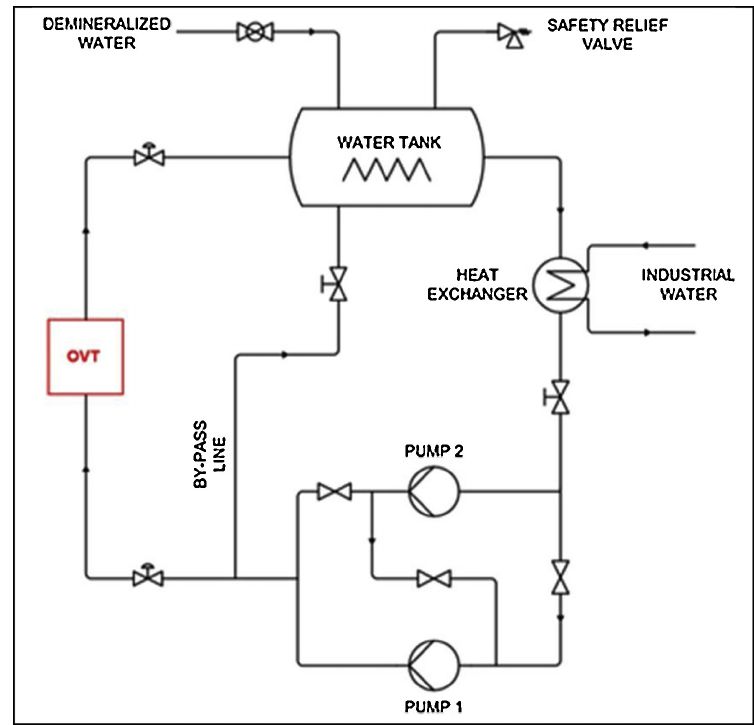
Figure 2. Simplified scheme of the CEF1